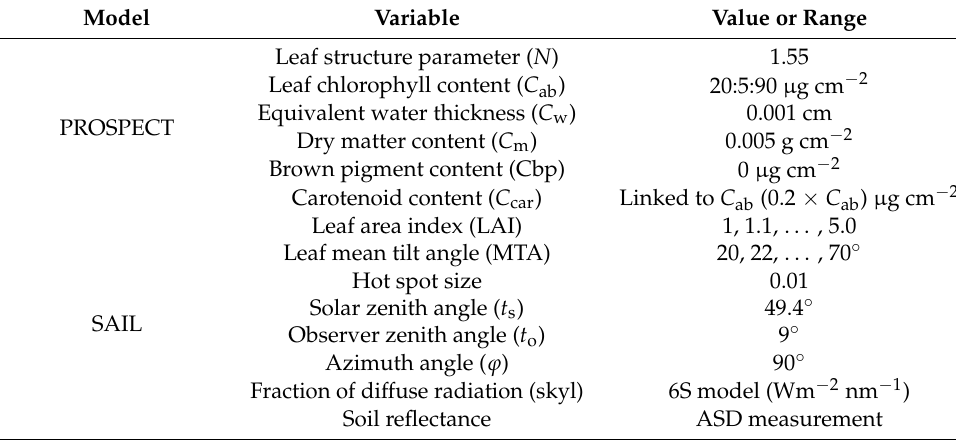
Table 1. The variable settings of the PROSAIL model.